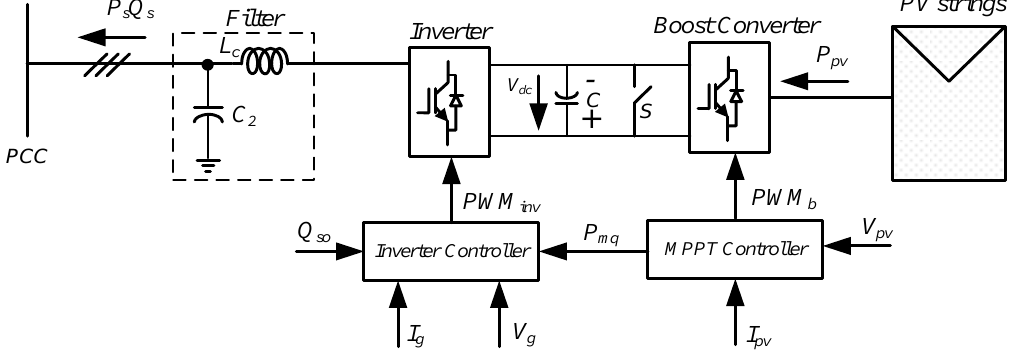
Figure 6. A sketch of single-phase PV-grid system.